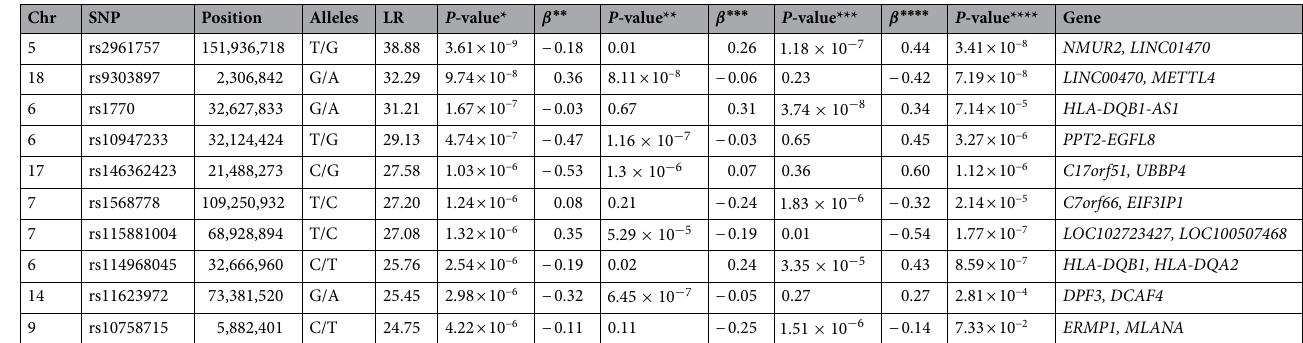
Table 2. The top 10 most significant SNPs. Chr, chromosome; LR, likelihood ratio; *, LR test; **, COPD- control; ***, asthma-control; ****,